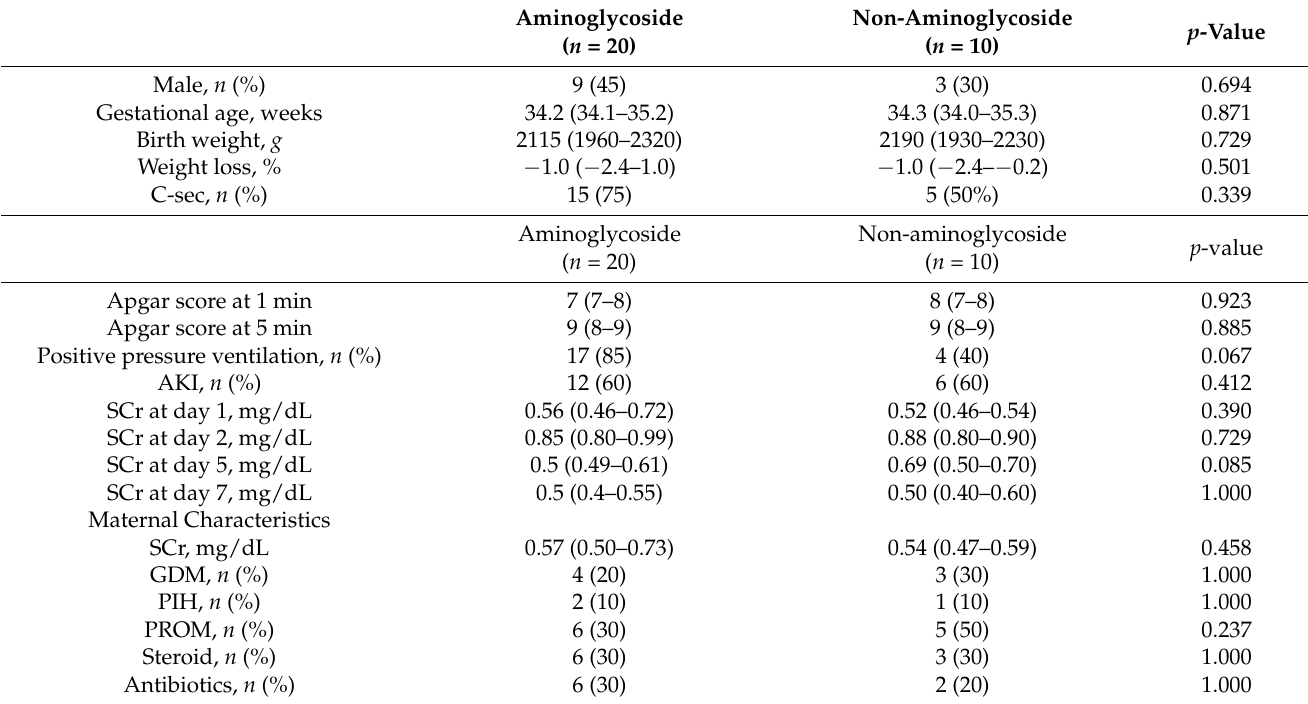
Table 4. Comparison of clinical characteristics between infants with and without aminoglycoside treatment.